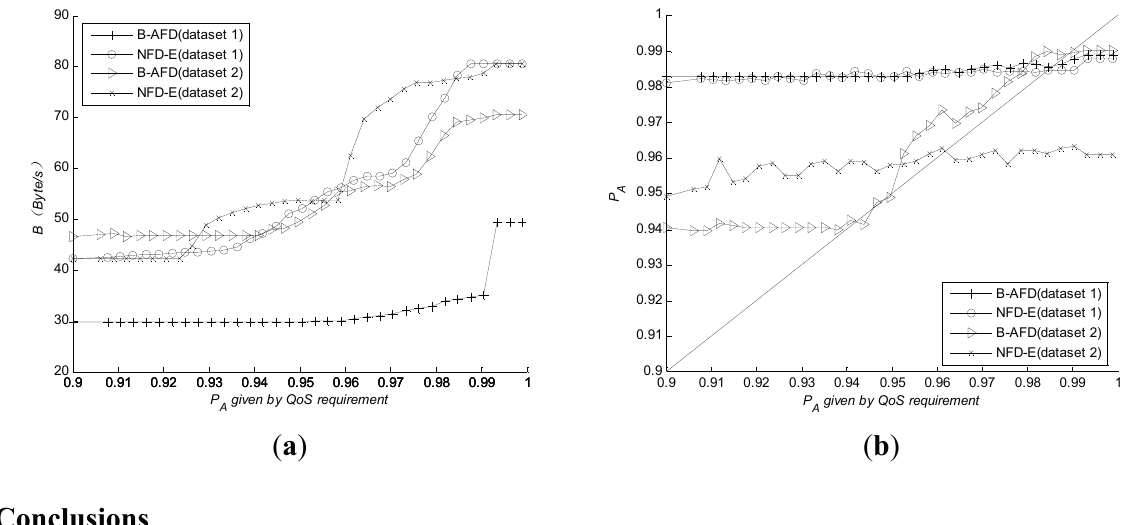
Figure 4. Comparisons with NFD-E. ( a ) Detection overhead ( b )